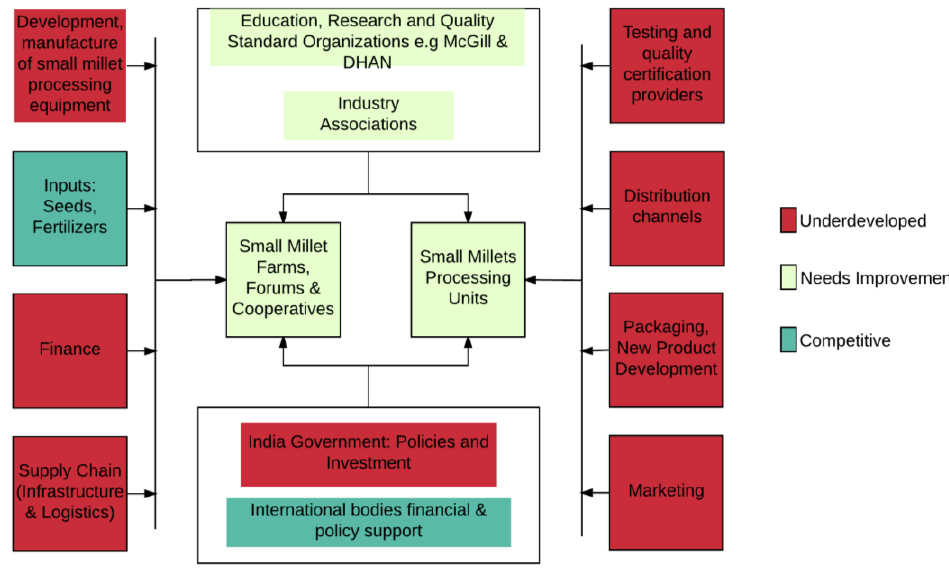
Figure 4. Cluster map and condition assessment of the Indian small millets value chain.